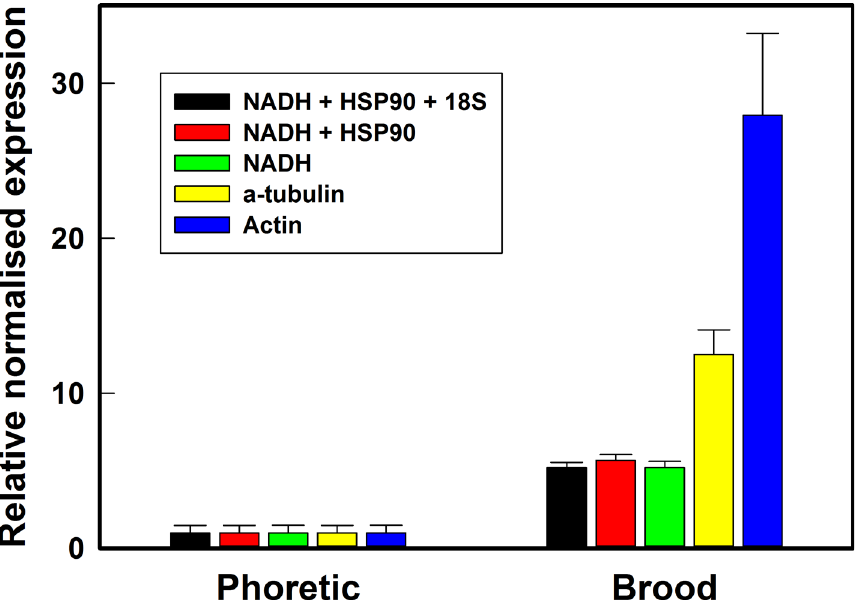
Fig 5. Validation of reference gene selection in a study of vitellogenin gene expression. Expression levels vitellogenin transcript was measured in brood phase mites (reproductive) relative to levels in phoretic mites (non-reproductive) using a combination of the most stable three (NADH + HSP90 + 18S), two (NADH + HSP90) and single (NADH) reference genes, and the least stable reference genes (actin and α -tubulin). Data are Means ± SEM, n =